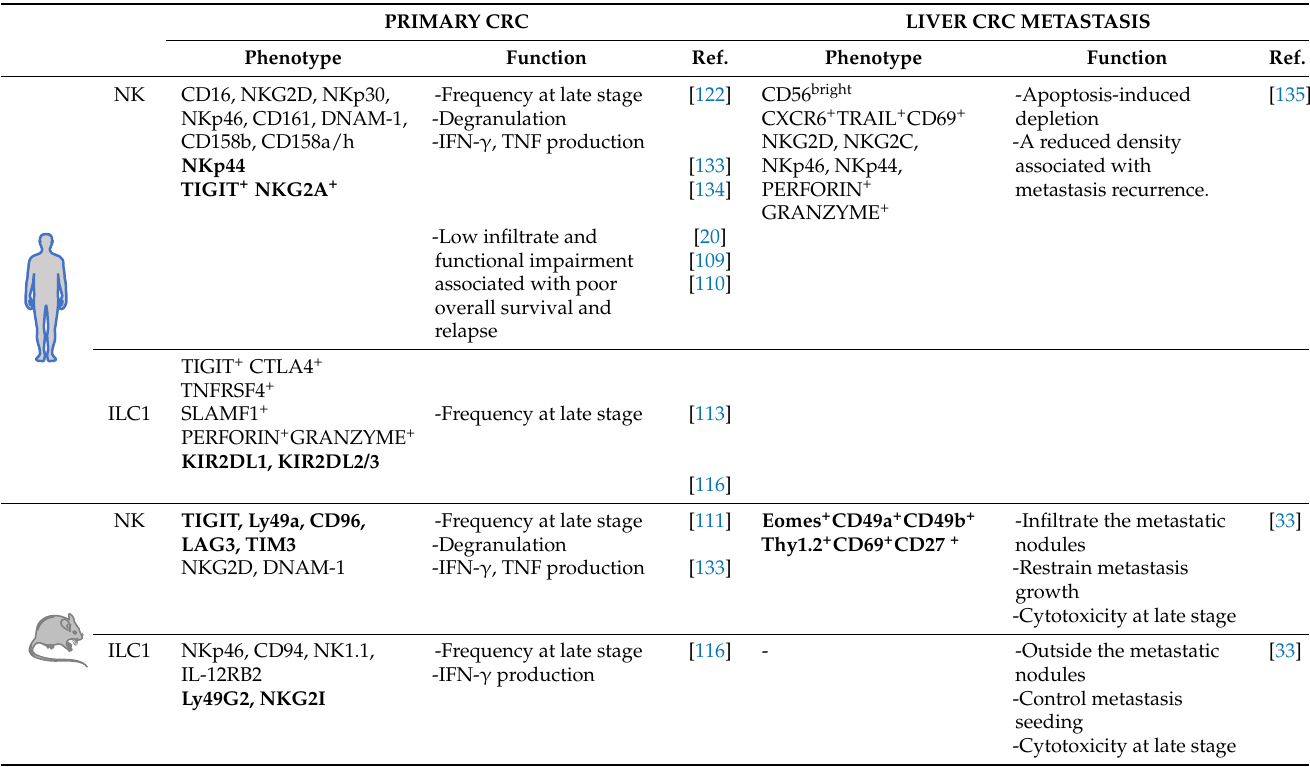
Table 1. Contribution of NK/ILC1 in CRC progression and metastasis. Grey: Decrease; Bold: Increase; -: Not determined.